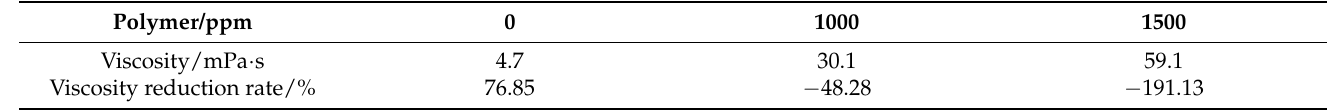
Table 3. Viscosity reduction results with different polymer